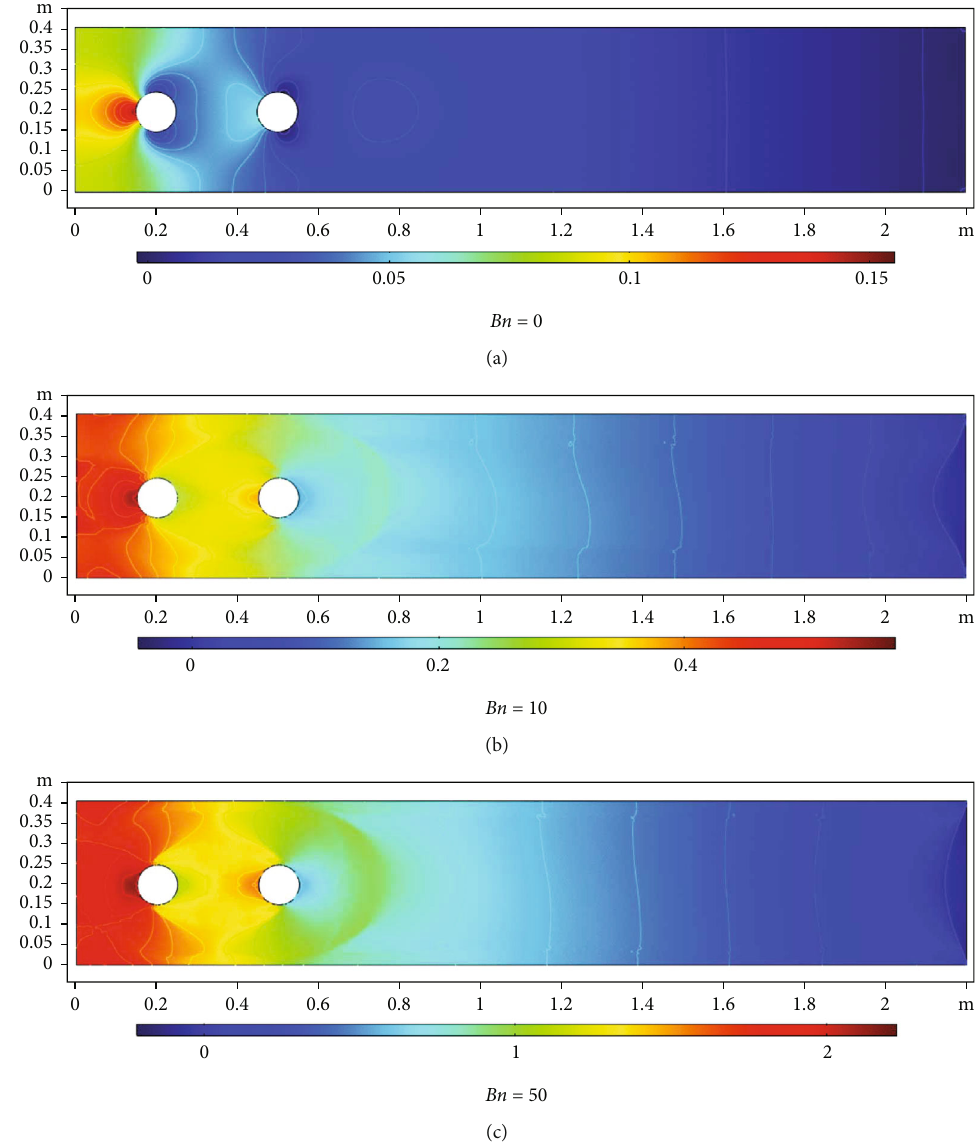
Figure 7: Pressure pro fi les for various Bn with G